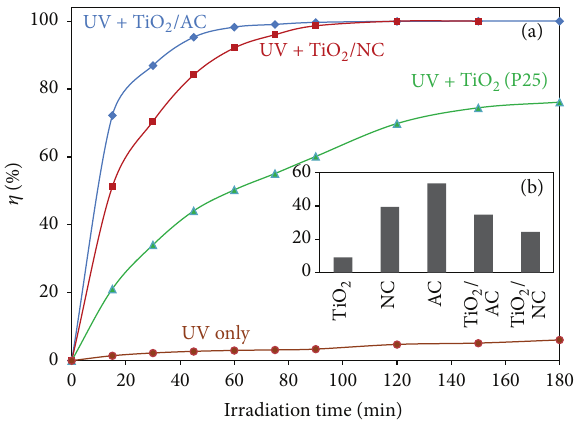
Figure 4: Photocatalytic degradation of MG by the different samples. The inset shows the maximum adsorption in the dark after 60 minutes (initial concentration of MG = 75 mg/L, photocatalyst amount = 1g/L, and irradiation time =